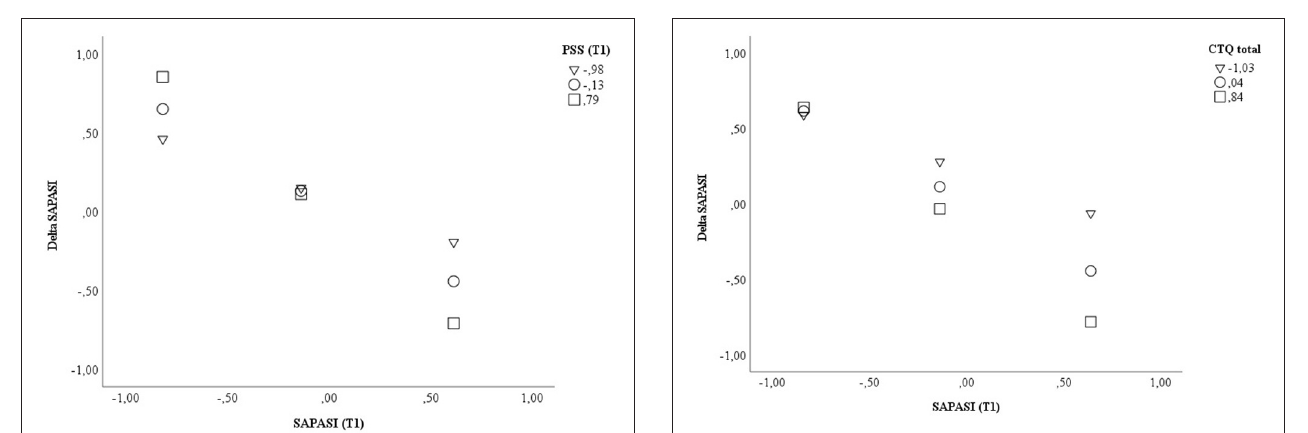
the final model (significance of change in F : p = 0.026) ( Supplementary Table S4a